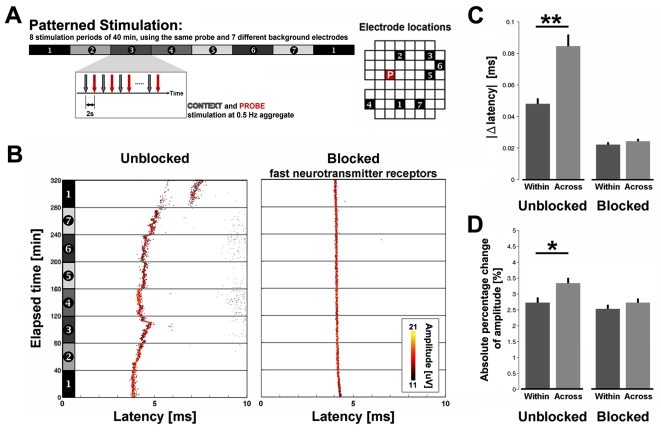
Action potential propagation depended on ongoing neural activity and stimulation pattern.(A) Experiment protocol. 1/4 Hz probe stimuli (red arrows) produced dAPs whose latencies and amplitudes were investigated for plasticity. A context electrode (gray arrows) was stimulated 2 sec prior to each probe stimulus, giving an overall 1/2 Hz stimulation frequency, and its location was shifted every 40 min to produce different patterns of stimulation (numbers and shaded bars). Right: electrode locations for data in B. (B) Example raster plots of a given dAP recorded on one electrode in response to probe stimulation of another electrode in culture media (left, Unblocked; sAPs are plotted with smaller markers) and when blocking sAPs (right, Blocked). Ongoing neural activity modified latency (x axis) and amplitude (color). Varying stimulation pattern (Across) significantly altered (C) dAP latency (**P<1e-6, Wilcoxon signed rank test for paired samples. Unblocked: n = 130 dAP trains; Blocked: n = 115 dAP trains. 6 cultures from 4 dissociations) and (D) amplitude (*P = 0.003) within 5 minutes (mean+s.e.m.). See Results.